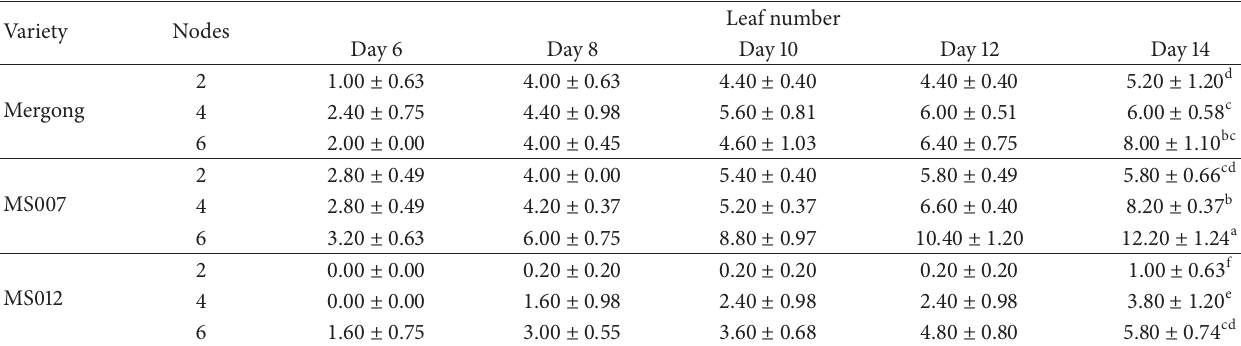
Table 3: Mean leaf number of three varieties having 2, 4, and 6 nodes cuttings from day 6 to day 14. Variety